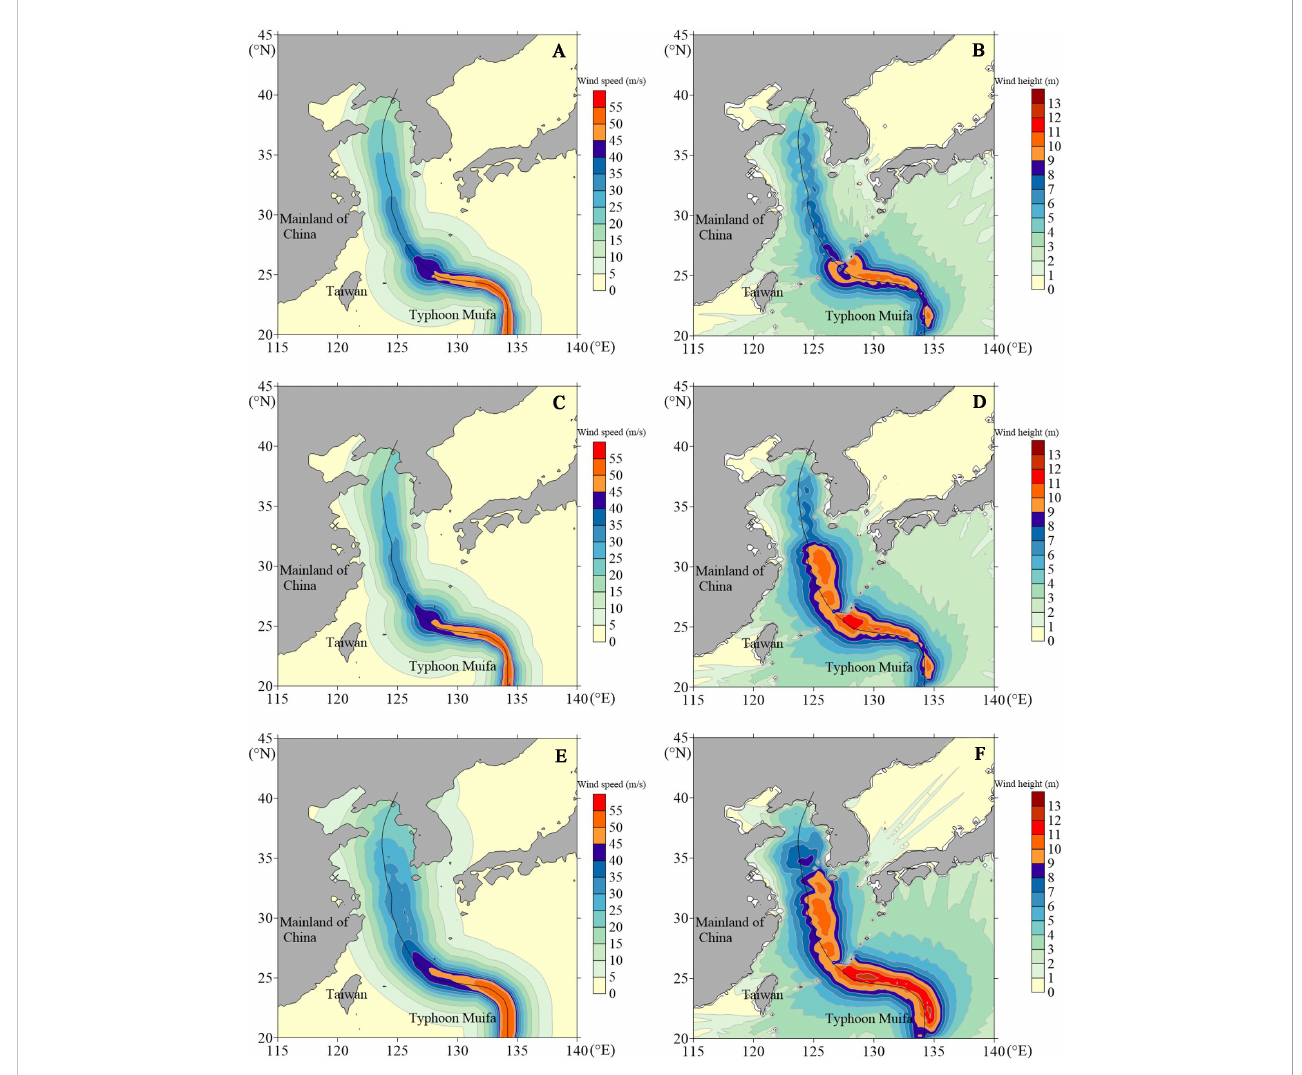
FIGURE 9 Distribution maps of the maximum wind speed fi eld and maximum wave height fi eld of Typhoon Muifa: (A) wind speed of symmetrical wind fi eld, (B) wave height of symmetrical wind fi eld, (C) wind speed of superimposed wind fi eld, (D) wave height of superimposed wind fi eld, (E) wind speed of asymmetric wind fi eld, (F) wave height of asymmetric wind fi